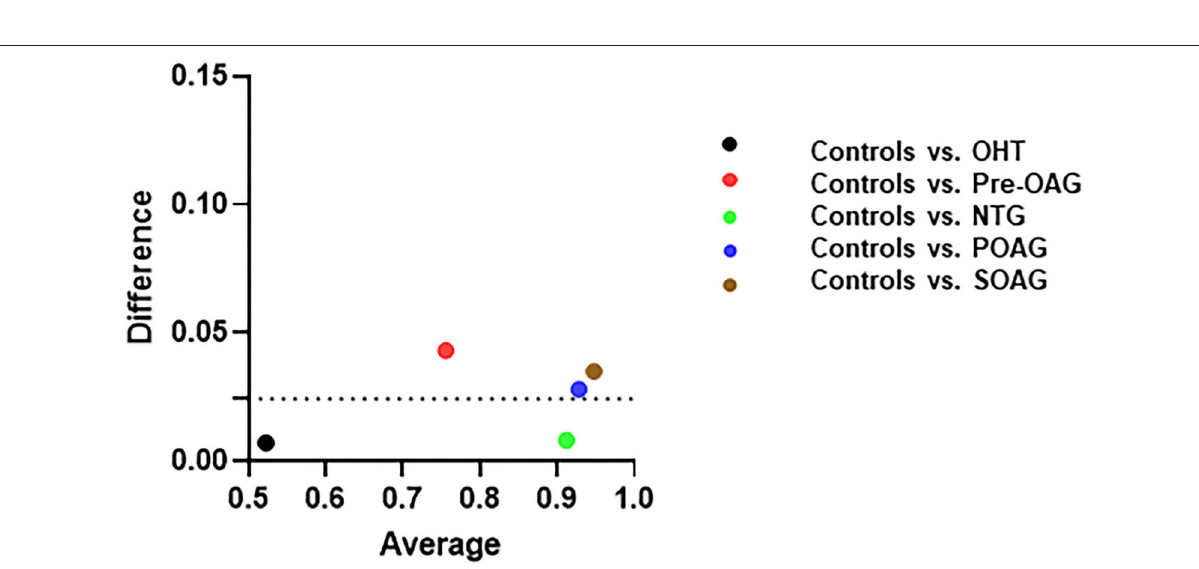
Frontiers in Medicine |